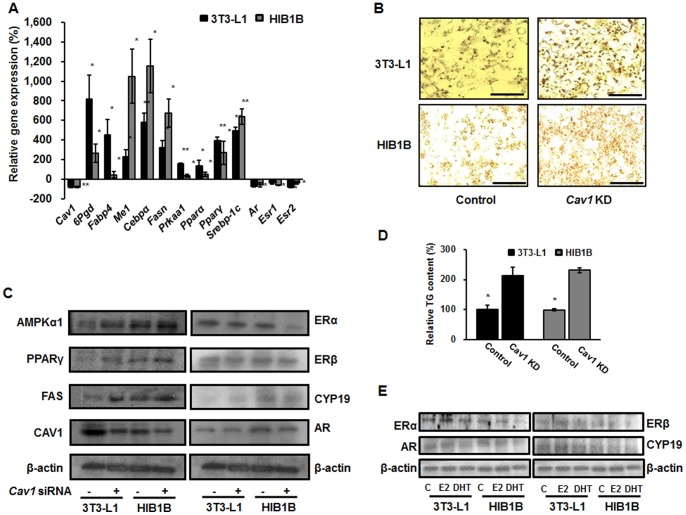
Effect of Cav1 knockdown (KD) on mRNA expression levels of major metabolic and sex hormone receptors in 3T3-L1 and HIB1B adipocytes (A), fat accumulation (B), protein expression levels of major metabolic and sex hormone receptors (C), triglyceride content (D), as well as protein expression levels of estrogen receptors, androgen receptor, and aromatase before and after sex hormone treatments (E).Scale bar represents 50 µM and 25 µM, respectively. Statistical significance between different groups was calculated by Student’s t-test, where *p<0.05 and **p<0.01.